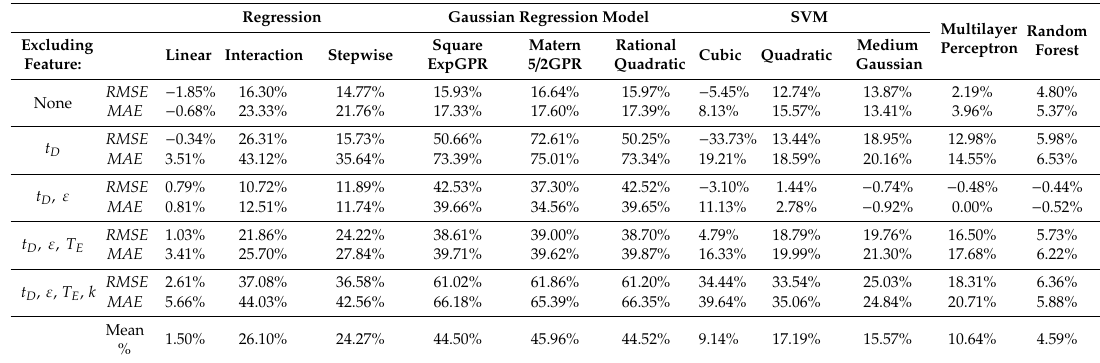
Table 9. Variation of MAE (500 sets of values) when “Contrast Rear” is excluded as predictive feature MAE without ∆ TR − MAE with ∆ TR × 100. calculated as: MAE with ∆ TR